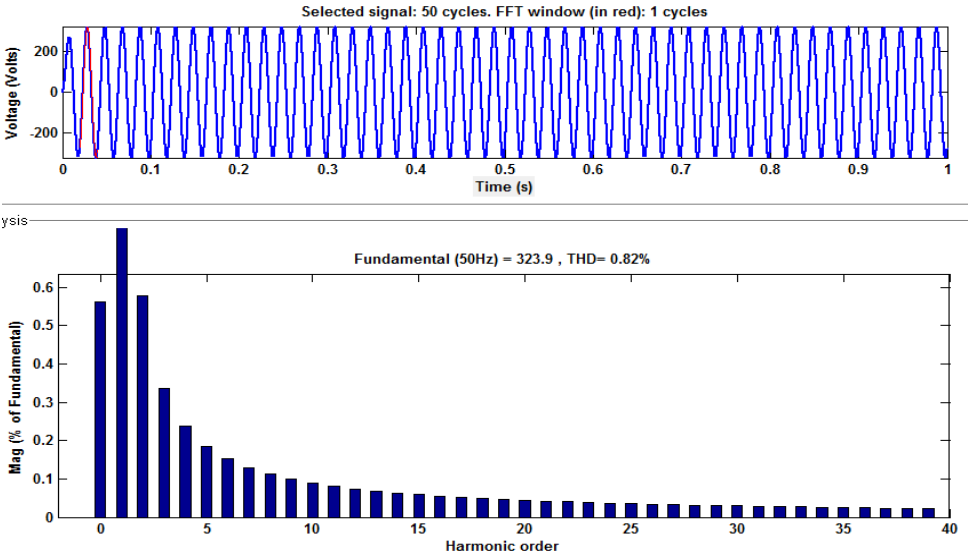
Figure 13. The THD of the converter using the SVPWM controller.